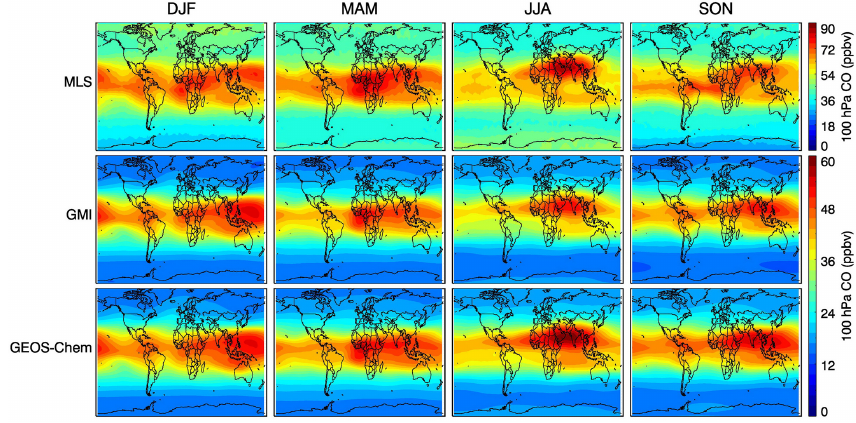
Figure 3. As in Fig. 1, but for CO mixing ratio at 100hPa.